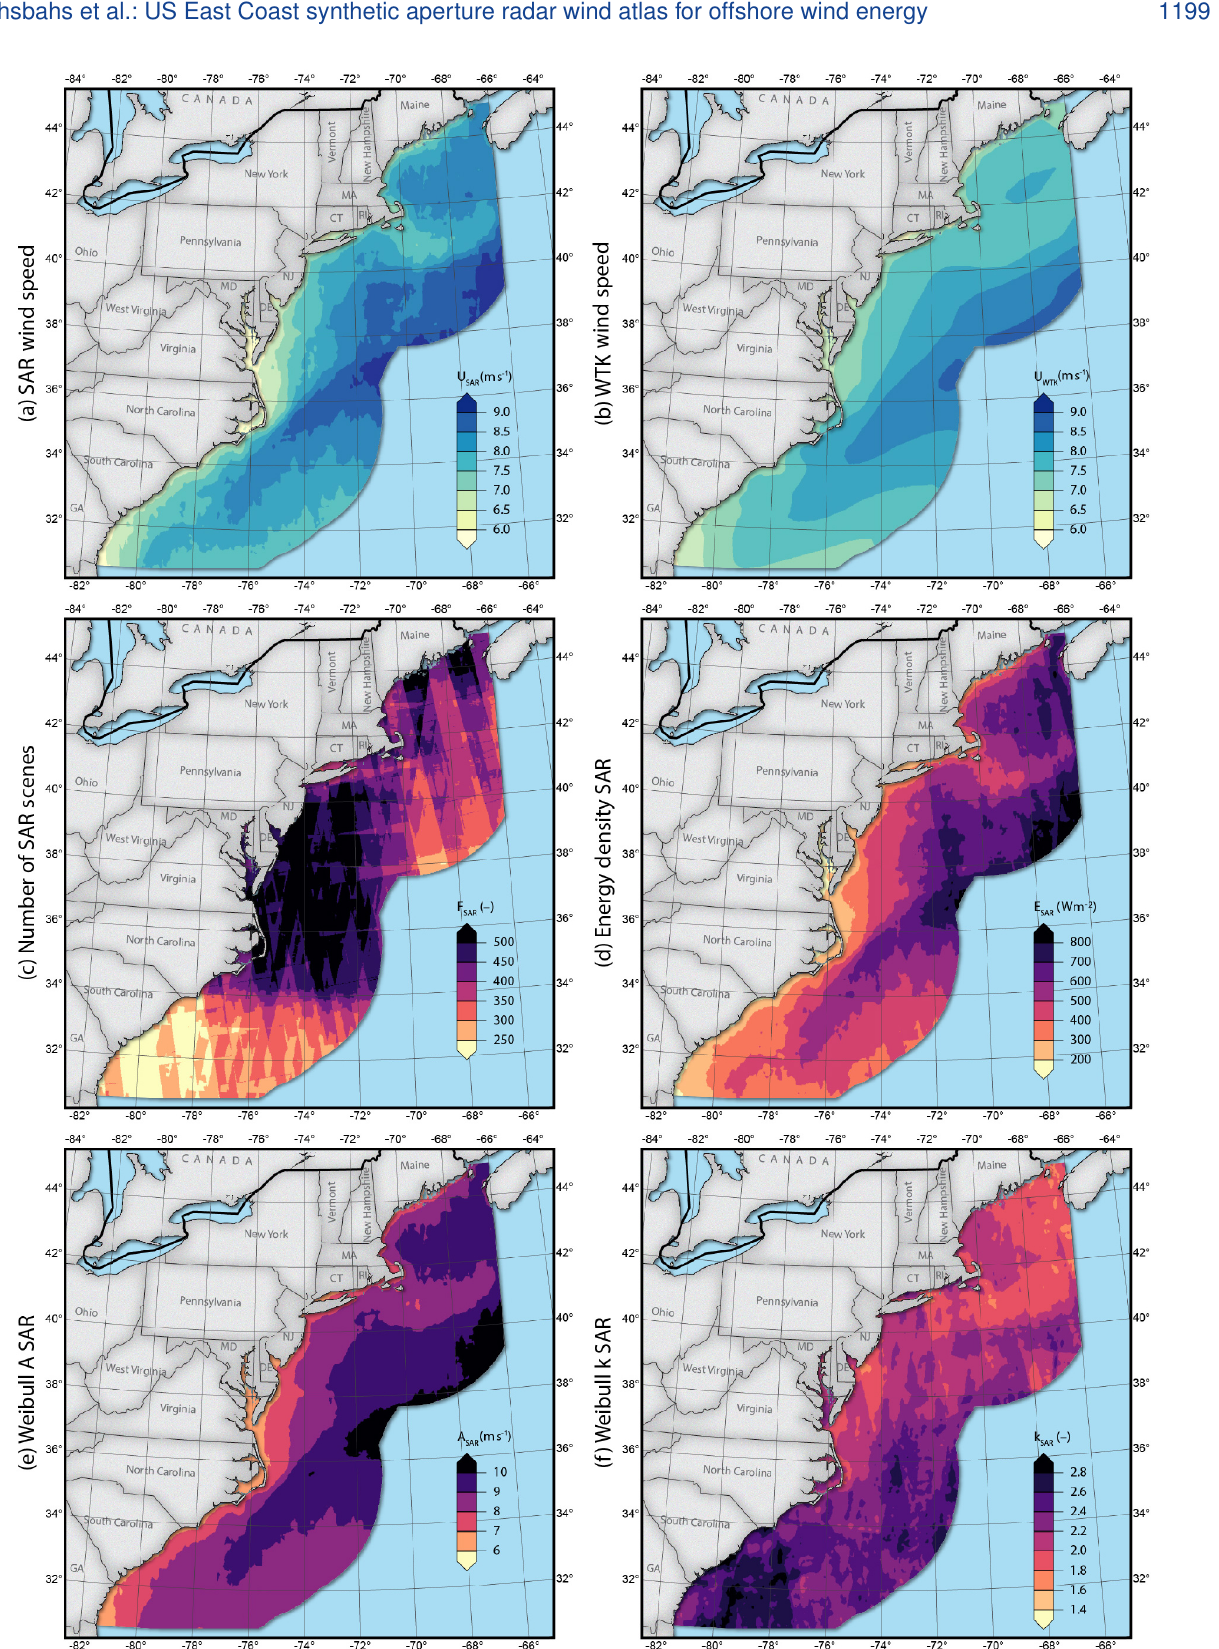
Figure 4. Wind atlas at 10ma.s.l. (above sea level): (a) arithmetic mean wind speed from SAR, (b) mean wind speed from WTK, (c) number of SAR samples, (d) SAR energy density, (e) SAR Weibull scale parameter A , (f) SAR Weibull shape